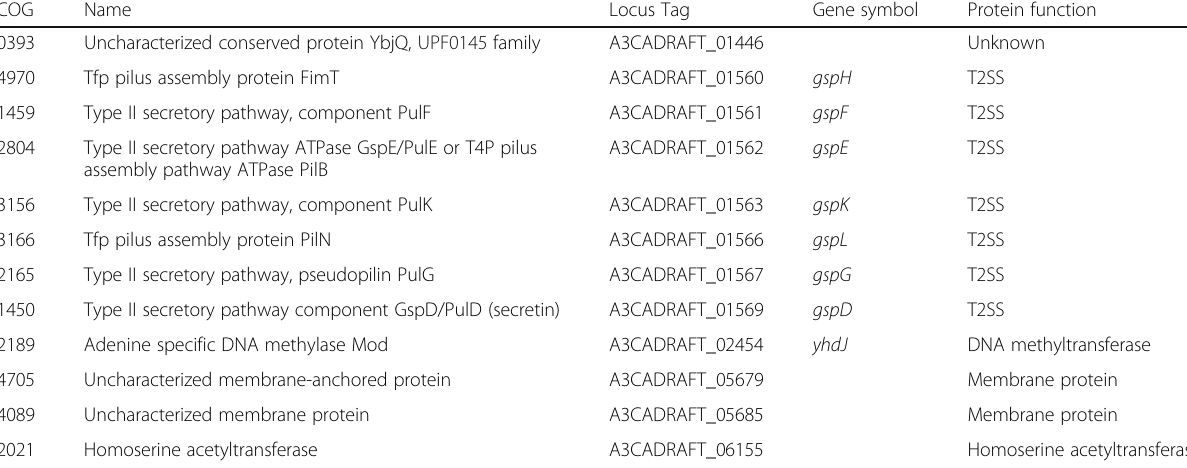
Table 6 List of the unique COGs in Ensifer meliloti Mlalz-1 COG